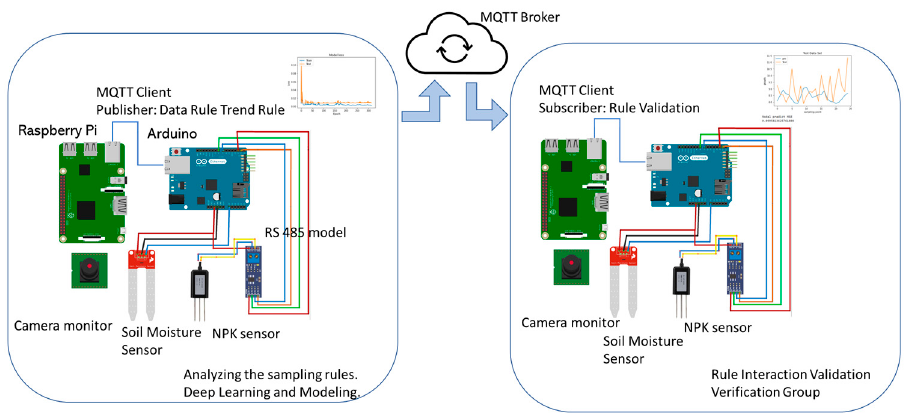
Figure 3. Experimental environment hardware and communication system architecture.